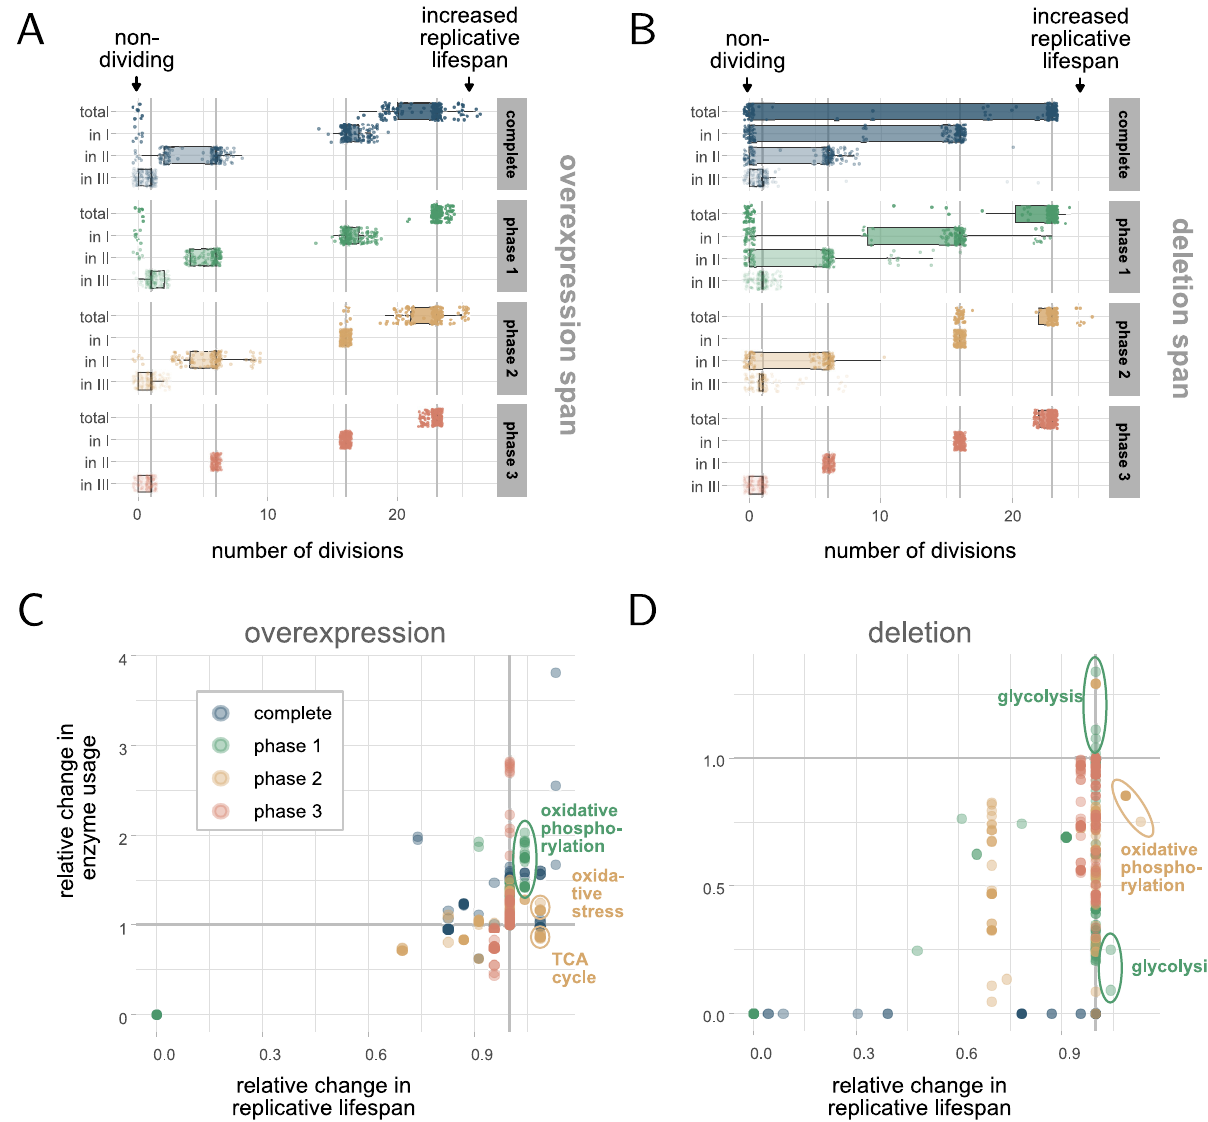
Fig 4. Effect of enzyme perturbations on lifespan. The simulations are based on f 0 = 0.0001 and r 0 = 0.0005 (as in Fig 2B) and perturbations (deletion or overexpression) in individual enzymes or isoenzyme combinations (140 + 23 cases) for different phases in the metabolic model. (A-B) Distribution (line: median, box: IQR, whiskers: median ± 1.5 IQR) of the number of divisions in total and in particular phases upon overexpression or deletion of enzymes during specific times (facets) in relation to the wildtype (grey lines). An intervention in a specific phase can have a different effect than an intervention over the whole lifespan. (C-D) Relation between replicative lifespan and total enzyme usage relative to the wildtype. Each dot represents one simulation with the perturbation in a specific phase of an enzyme/isoenzymes. Both enzyme deletion and overexpression can lead to an increased but also decreased total usage of the enzyme compared to the